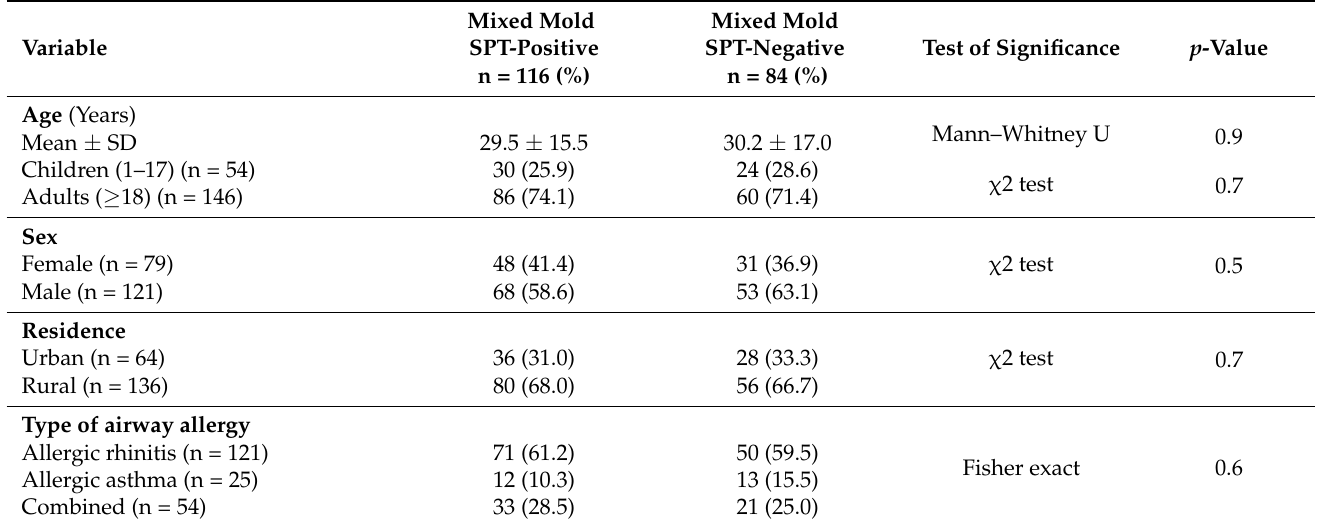
Table 2. Variables associated with patterns of mixed molds sensitization in studied patients (N=200).